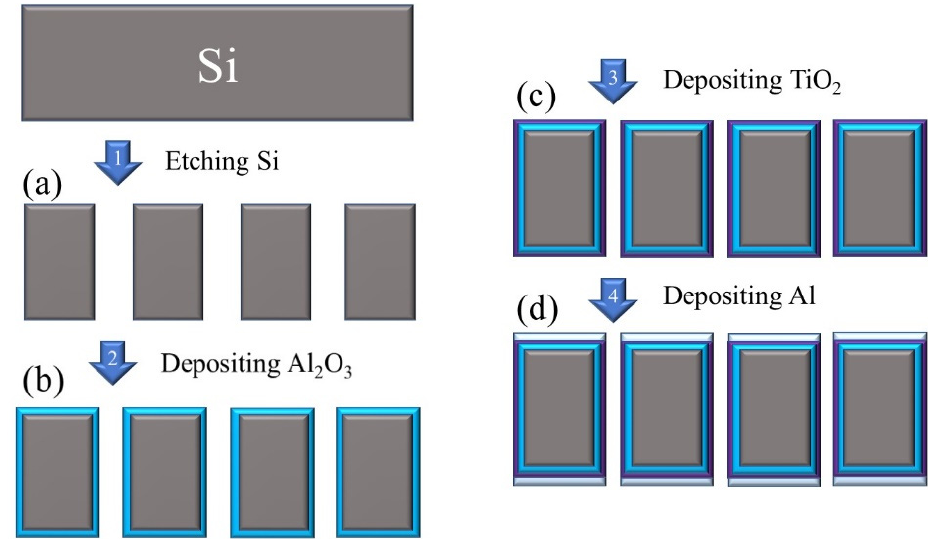
Figure 2. The sensor fabrication process diagram for (a) etching Si, (b) depositing Al 2 O 3 , (c) depositing TiO 2 , and (d) depositing Al, respectively.